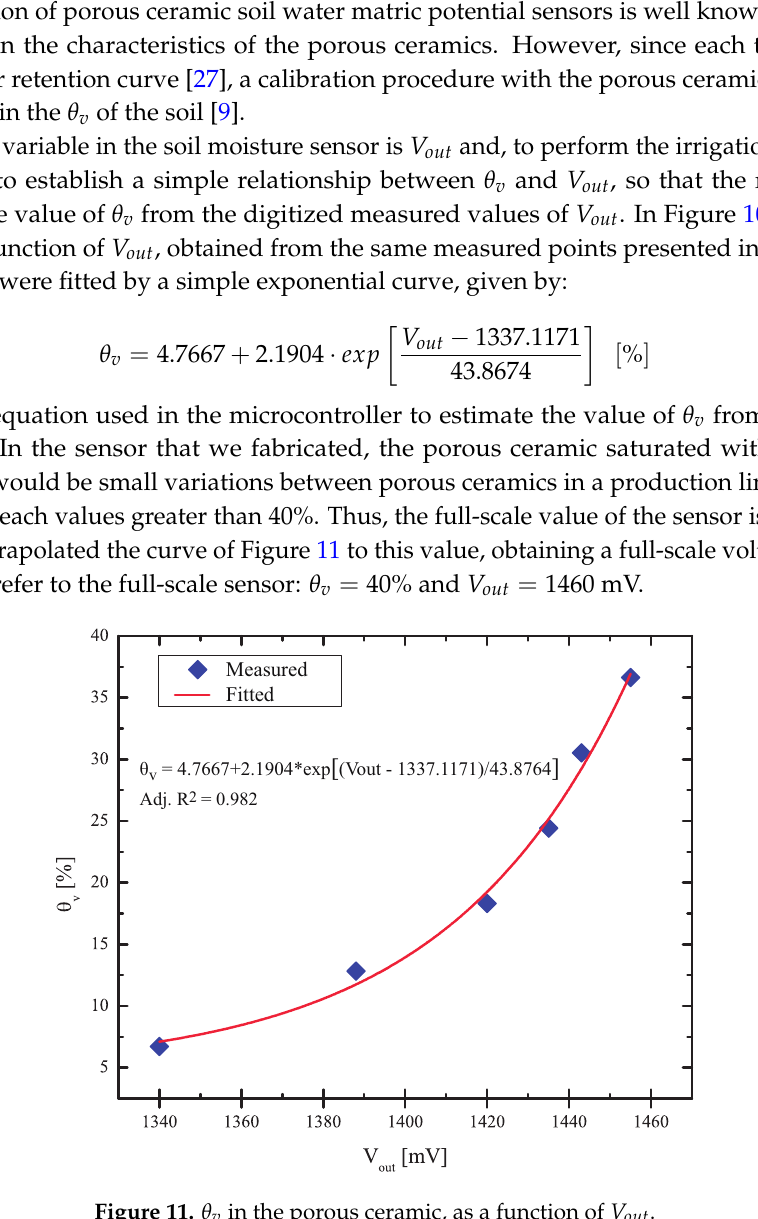
Figure 11. θ v in the porous ceramic, as a function of V out